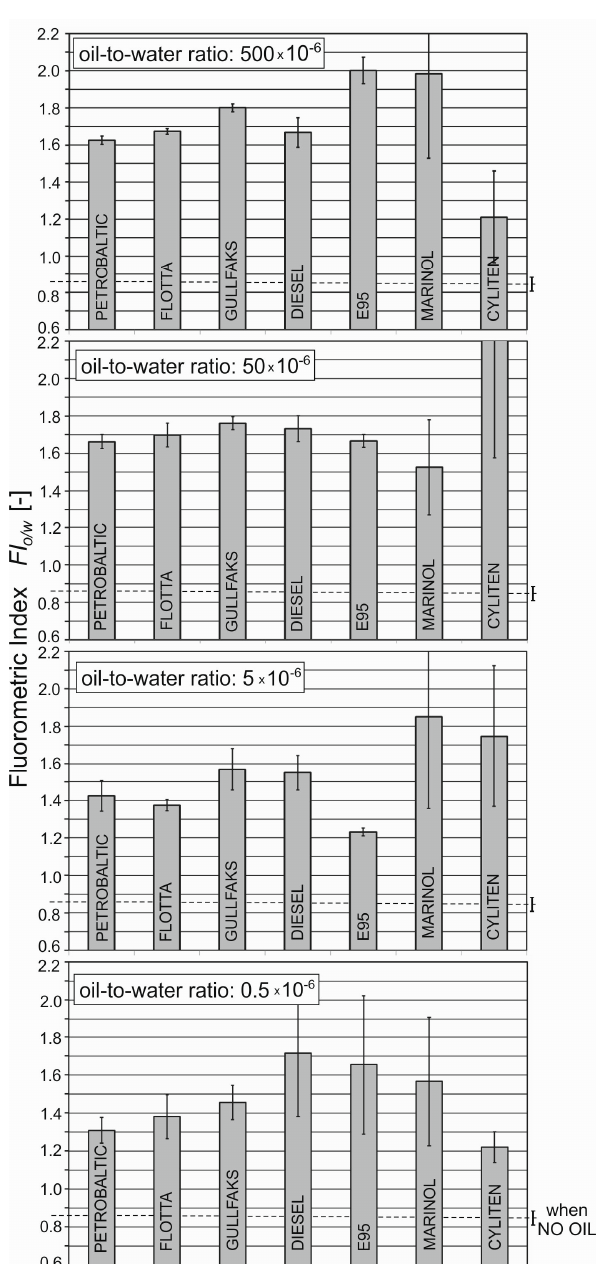
Figure 4. Mean values of fluorometric index confidence intervals of the mean (the significance level was 0.05) for natural seawater (no oil) and seawater artificially polluted by different kinds of oil for oil-to-water ratios of 0.5 × 10 − 6 , 5 × 10 − 6 , 50 × 10 − 6 , and 500 × 10 − 6 .